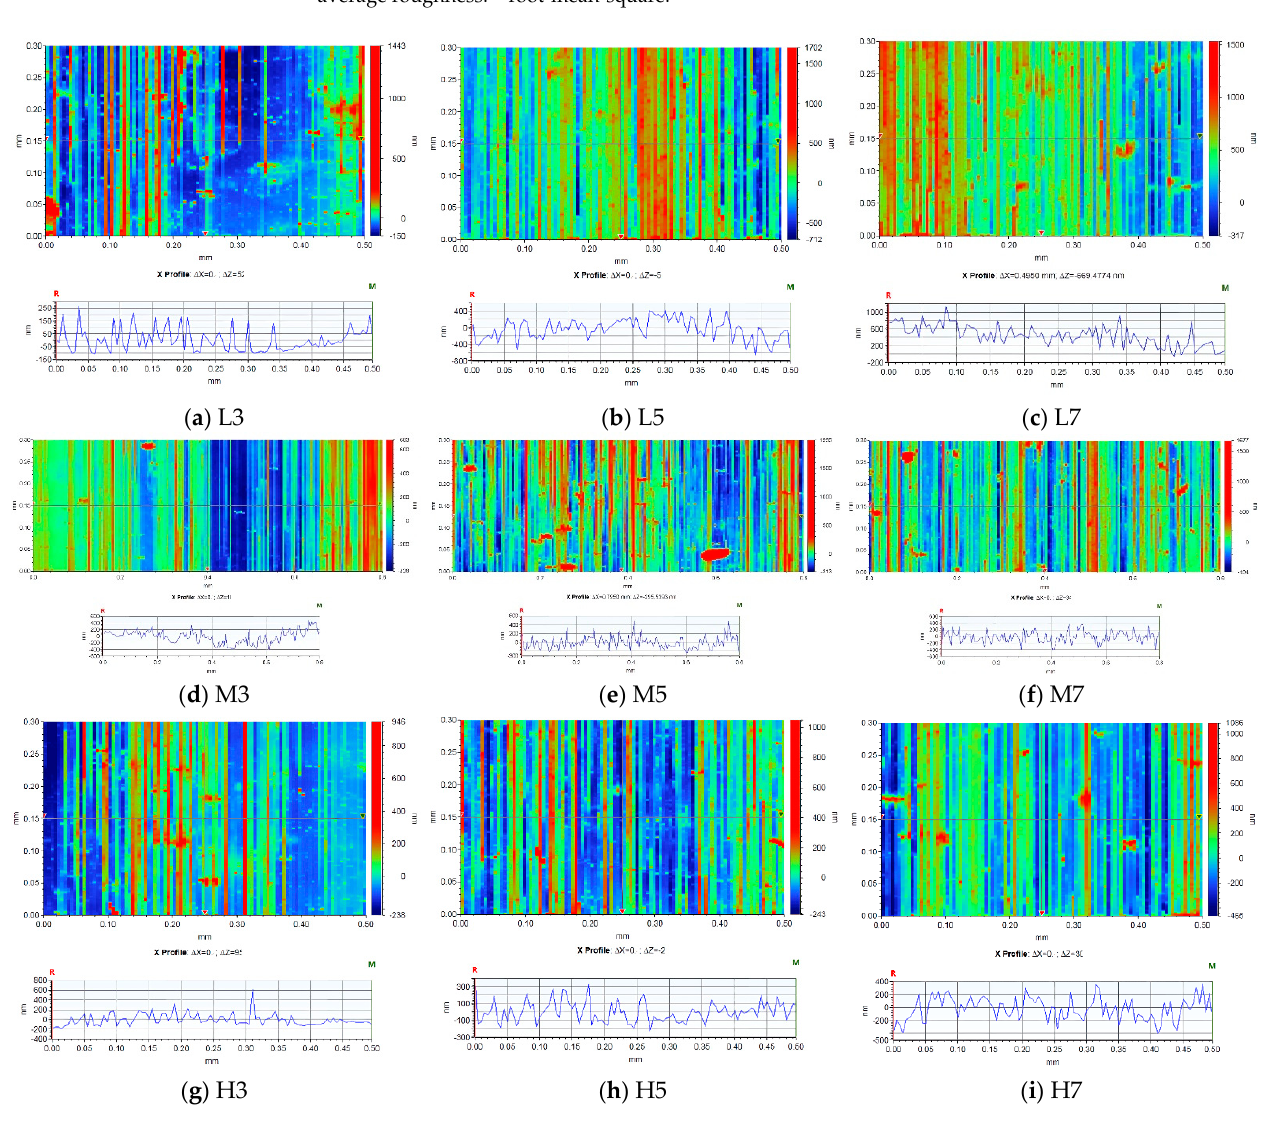
Figure 3. Step measurement images of L3, L5, and L7 (top row), M3, M5, and M7 (middle row), and H3, H5, and H7 (bottom row). Compared to the center line, the average surface curvature is largest in the L group, and the number of curvatures is highest in the M group. The average roughness values were ~70–450 nm in the L group, 110–150 nm in the M group, and 100–150 nm in the H group. In the slow L group, the number of coatings remarkably affected the average roughness.